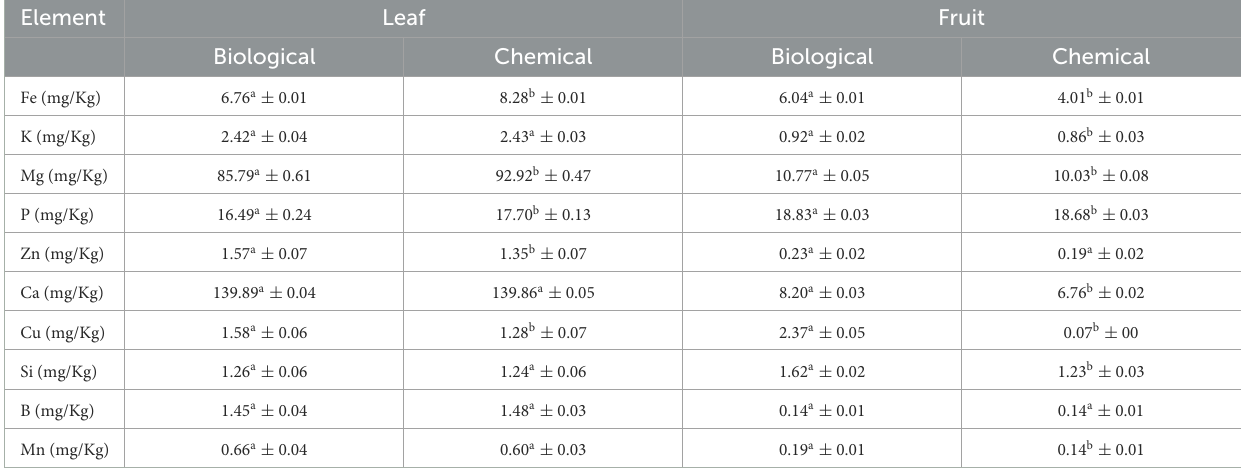
TABLE 3 Concentration of some macro- and micronutrients in the leaf and fruit of sweet pepper plants. Element Leaf Fruit Biological Chemical Biological Chemical